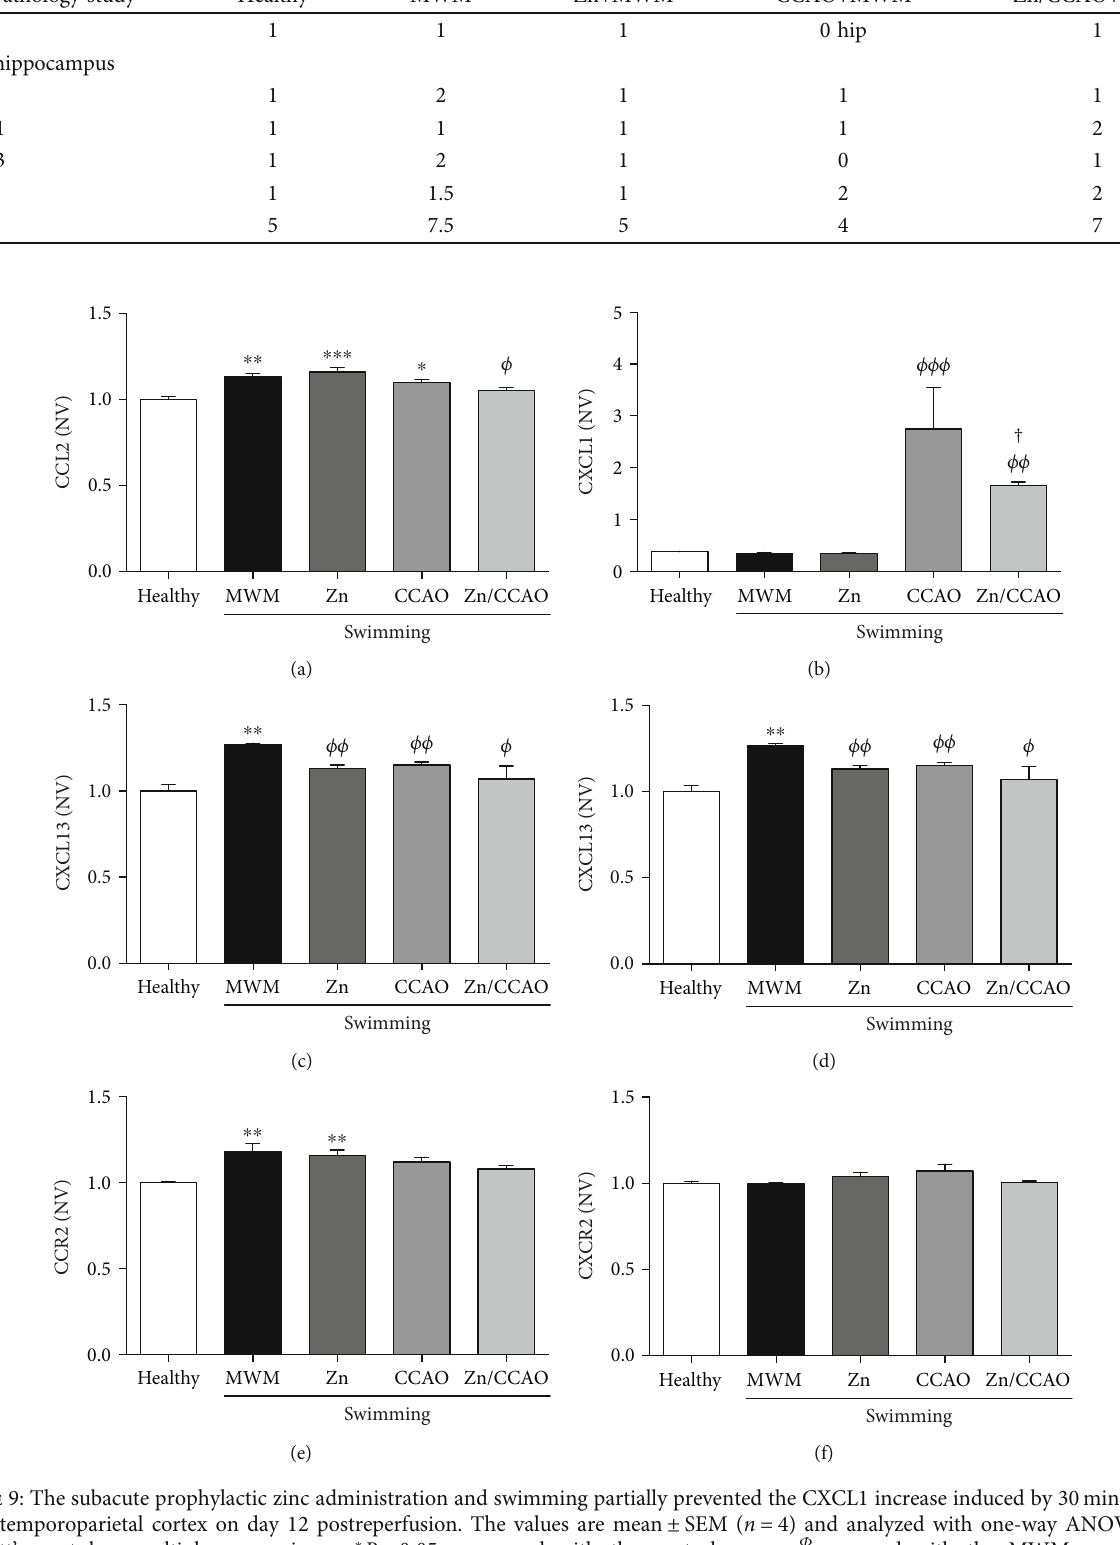
Table 4: Hierarchization score of the protective e ff ect of pharmacological strategies (HSPEPS) in histopathology study. Histopathology study